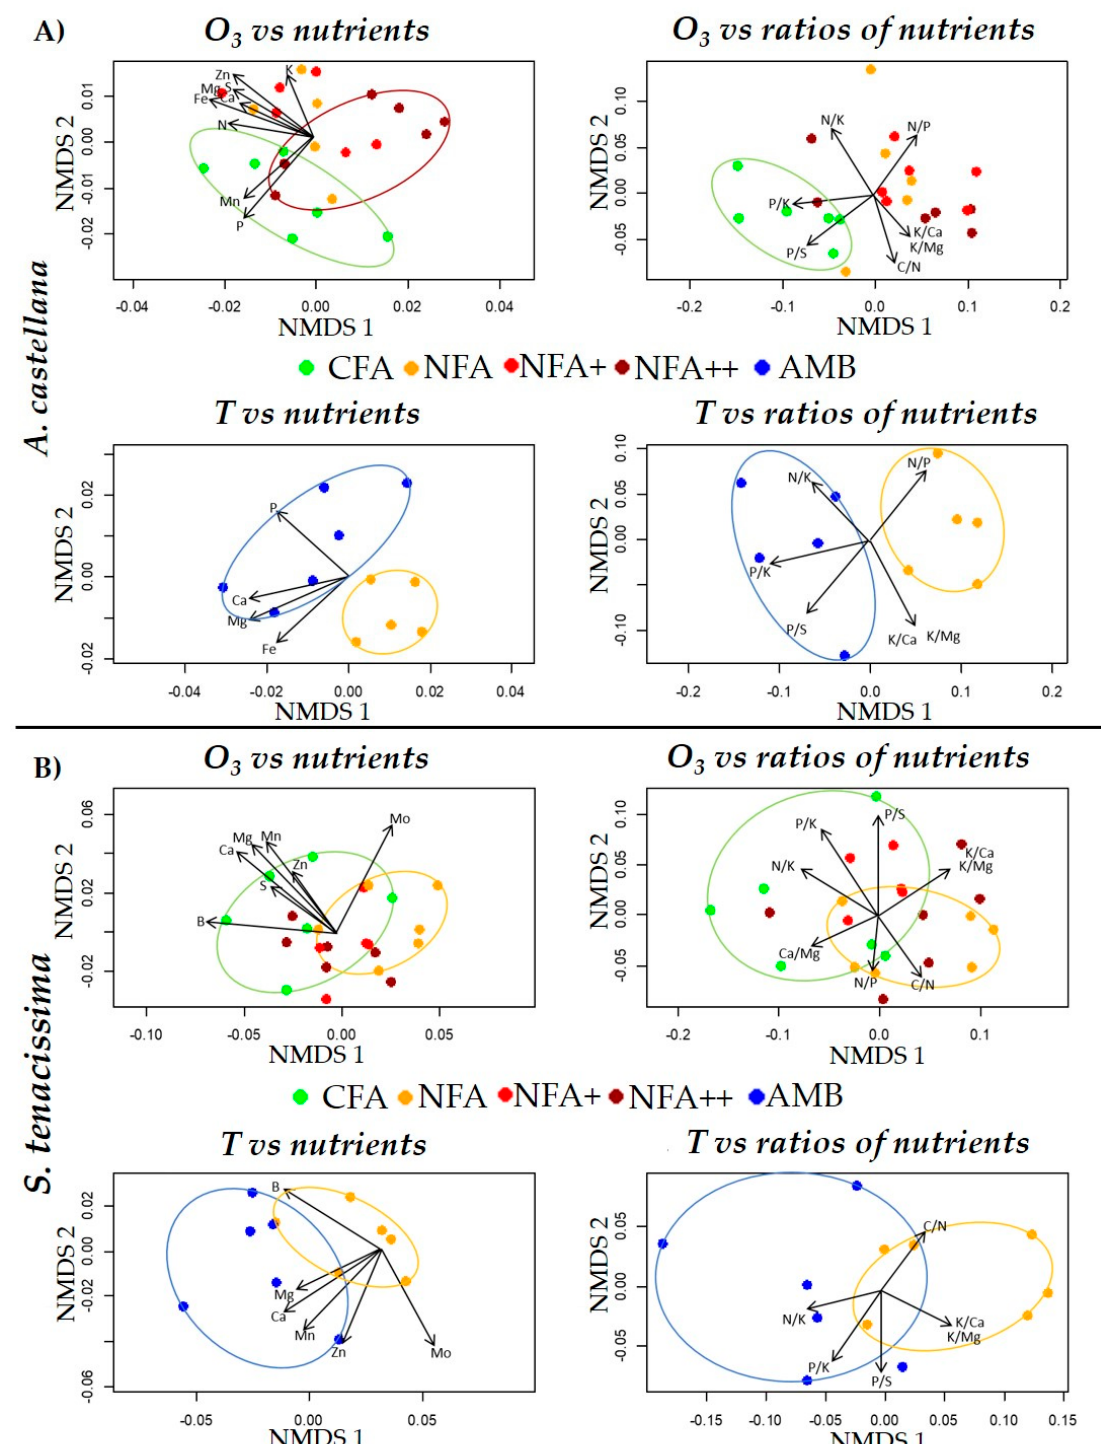
Figure 4. Non-metric multidimensional scaling (NMDS) of nutrients ( left ) and nutrient ratios ( right ) found in A. castellana ( A ) and S. tenacissima ( B ) in relation to O 3 and temperature (T) factors. The presence of colored ellipse represents significant differences among treatments following PERMANOVA results. Arrows denote significant correlations of nutrient or nutrient ratios with the NMDS axis.